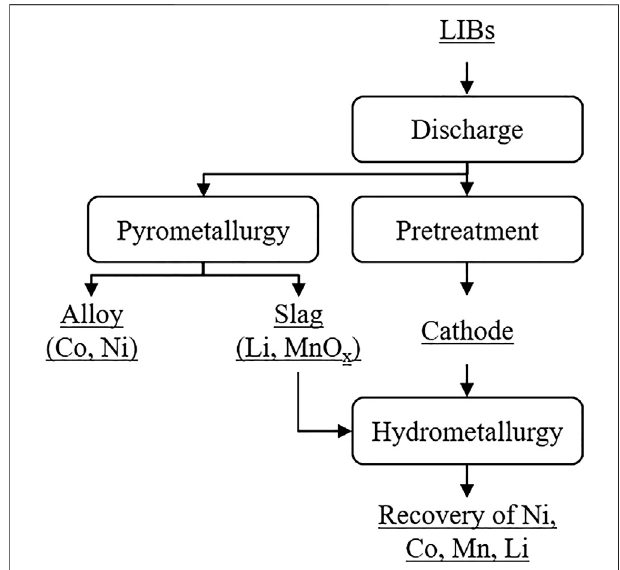
FIGURE 6 | Processes for the recycling of lithium-ion batteries (Mossali et al., 2020).